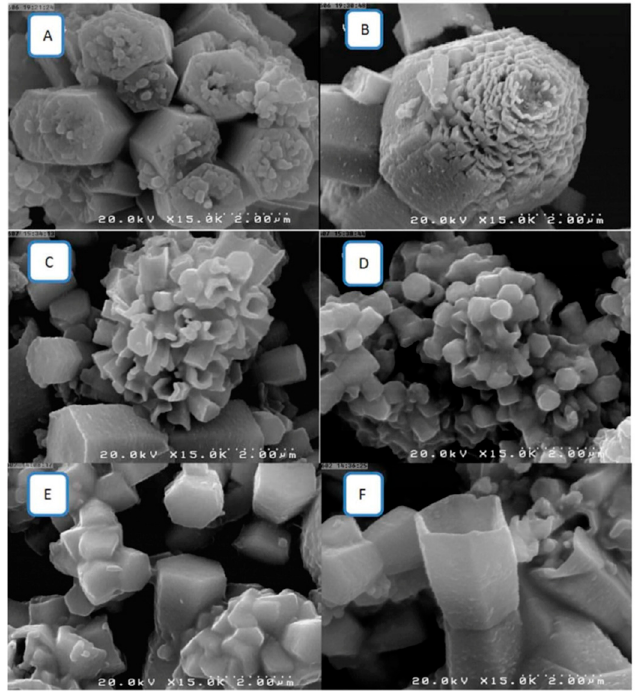
Figure 3. FESEM images of ZnO surface morphologies ( A ) before, and modification using oleic acid with different weight ratios ( B ) 2 mg, ( C ) 4 mg, ( D ) 6 mg, ( E ) 8 mg, ( F ) 10 mg [44].